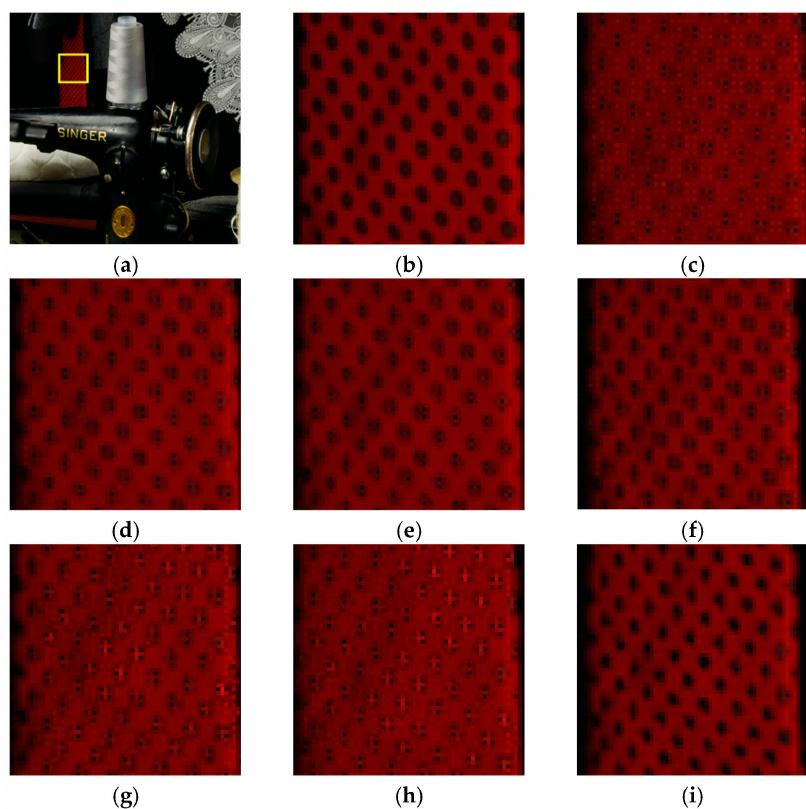
Figure 8. The processing results of image Figure 6h: ( a ) the original image marked with the yellow rectangular frame; ( b ) the polka dots of the tie in the yellow rectangular frame; ( c ) DLMMSE [9]; ( d ) LDI-NAT [29]; ( e ) LDI-NLM [29]; ( f ) VDI [18]; ( g ) RI [19]; ( h ) MLRI [21]; ( i ) the proposed